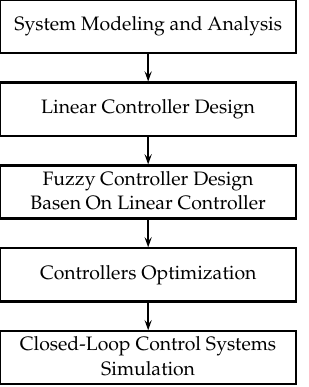
Figure 1. Methodology